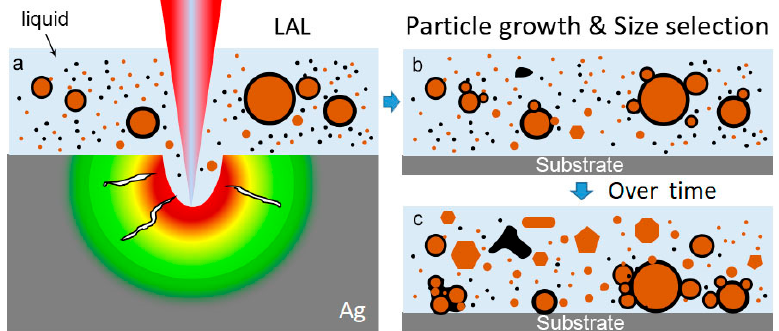
Figure 10. ( a – c ) Schematic of particle growth into polygonal nanocrystals, followed by the size separation of ultrasmall particles by large particle precipitation, due to carbon encapsulation. In the liquids, Ag and carbon are denoted by orange and black colored spheres,